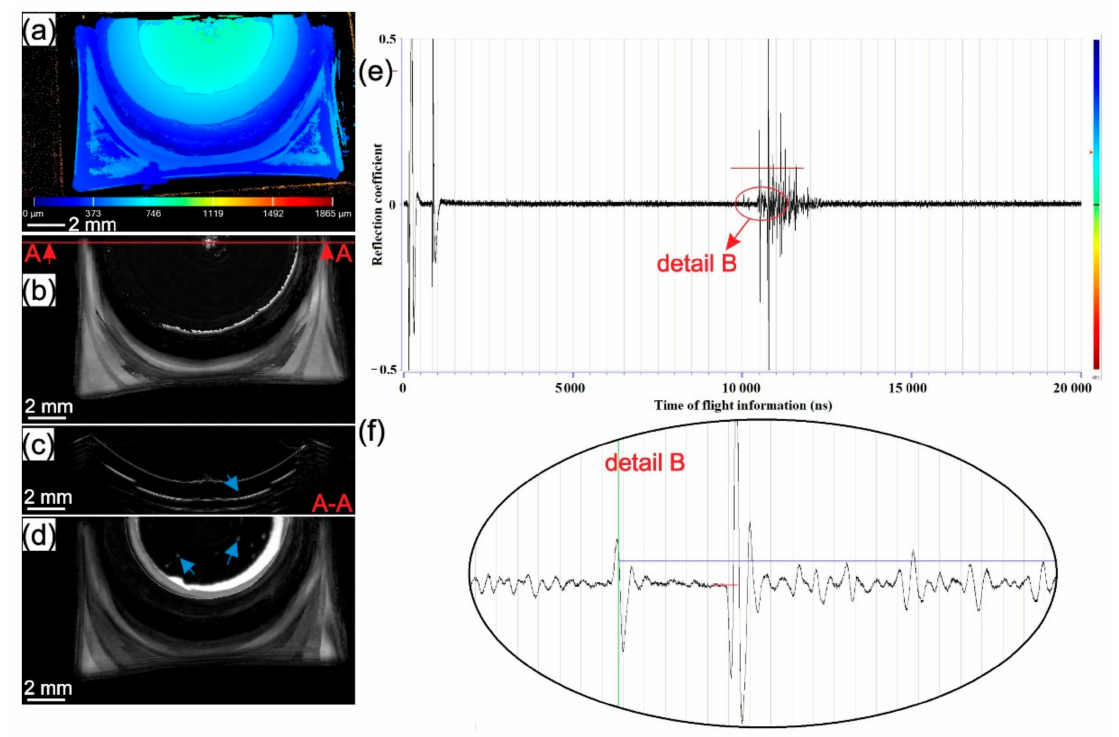
Figure 8. The sample from batch II welded with 2500 rpm: ( a ) topography map from the top surface; ( b ) C-scan with gate position 20 ns and gate length 50 ns with A-A cross-section showing the place where B-scan was obtained; ( c ) B-scan from A-A cross-section; ( d ) C-scan with gate position 220 ns and gate length 50 ns as shown in detail B with red line on A-scan;